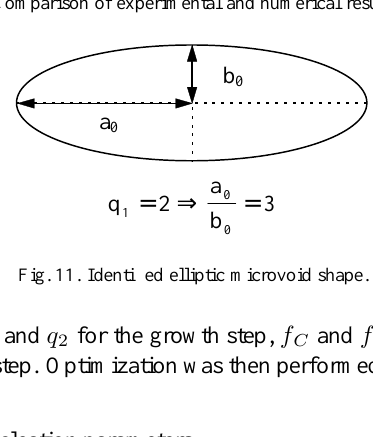
Fig. 10. Comparison of experimental and numerical results – Third optimization – (Punched tension specimens – 2024-T351 aluminium alloy).